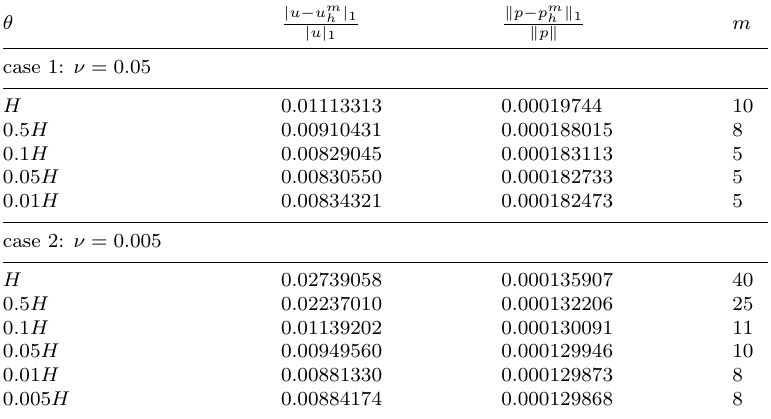
Table 1. Errors and numbers of Oseen iterations by one-level subgrid stabilized method with different stabilized parameters.